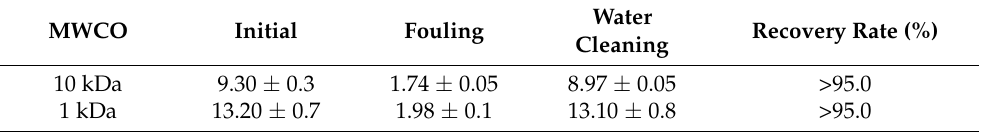
Table 8. Recovery effects of membrane flux (L · h − 1